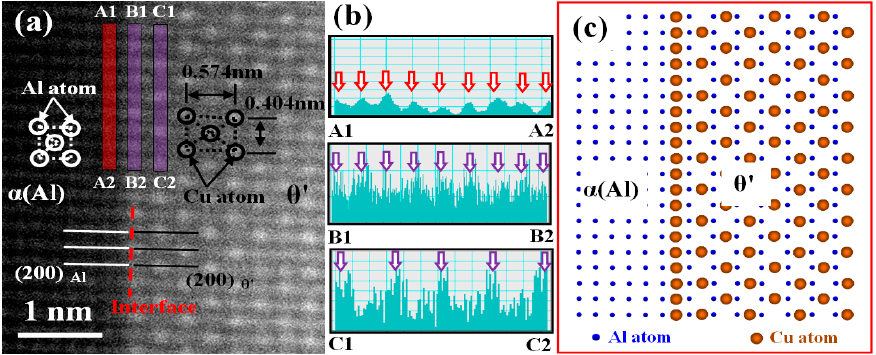
Figure 19. The interface of the θ ´ phase in Figure 18b. ( a ) Z-contrast image; ( b ) image intensity profiles; ( c ) schematic diagram of the atomic positions.